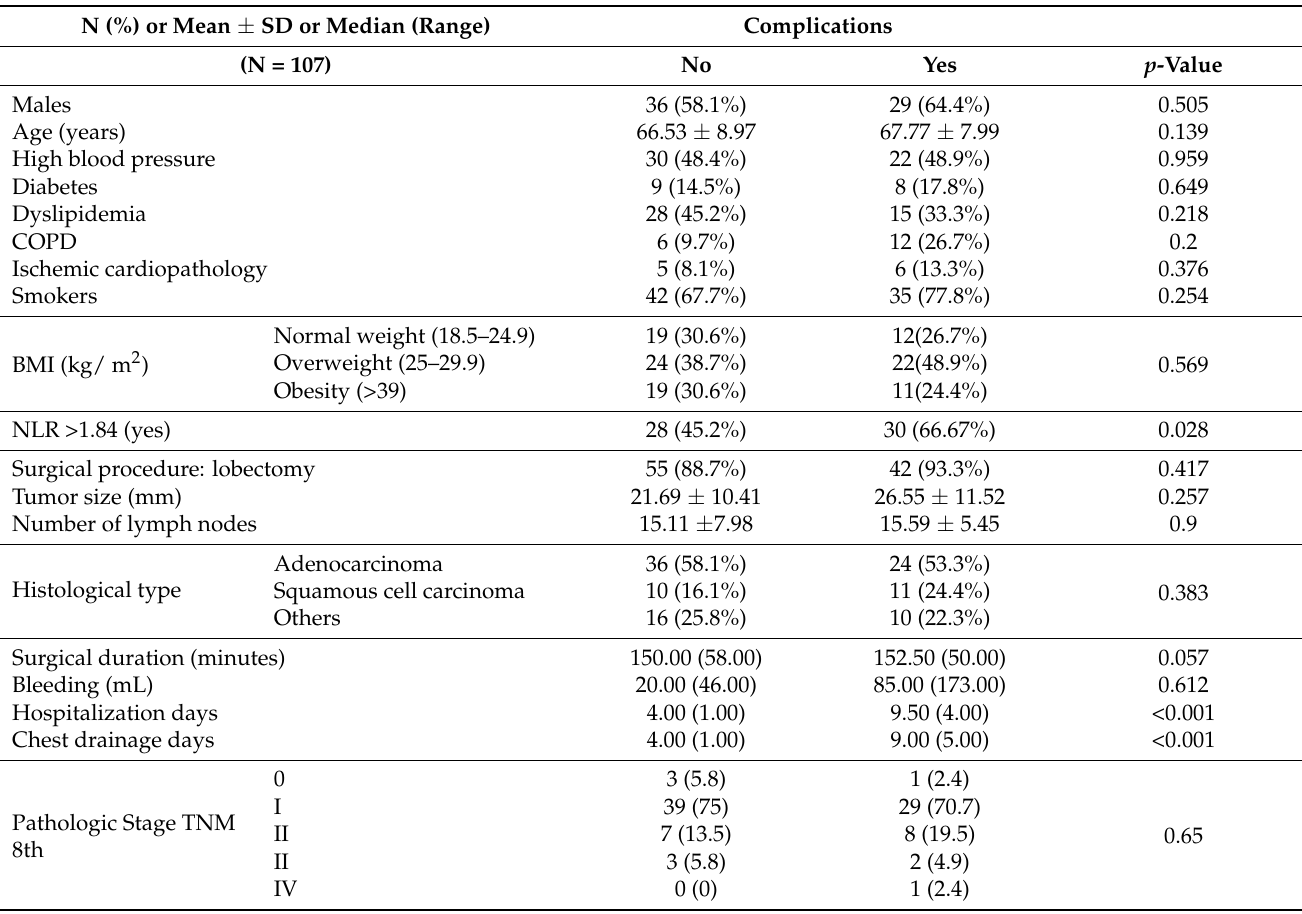
Table 3. Postoperative complications according to clinical, pathological, and systemic inflammatory parameters and surgical analysis.